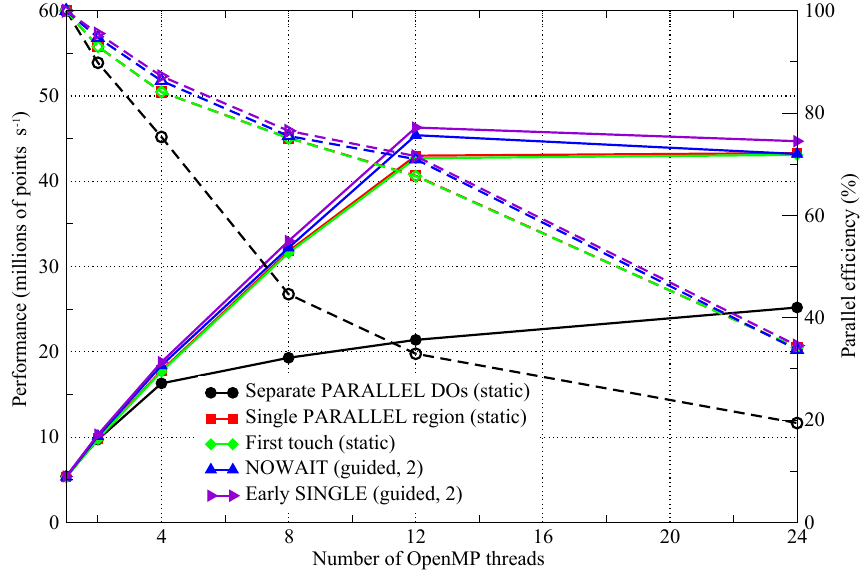
Figure 9. Performance of the OpenMP-parallel version of PSyKAl NEMOLite2D for the Cray compiler on a single Intel Ivy Bridge socket. The corresponding parallel efficiencies are shown using open symbols and dashed lines. The 24-thread runs employed hyperthreading and the optimal OpenMP schedule is given in